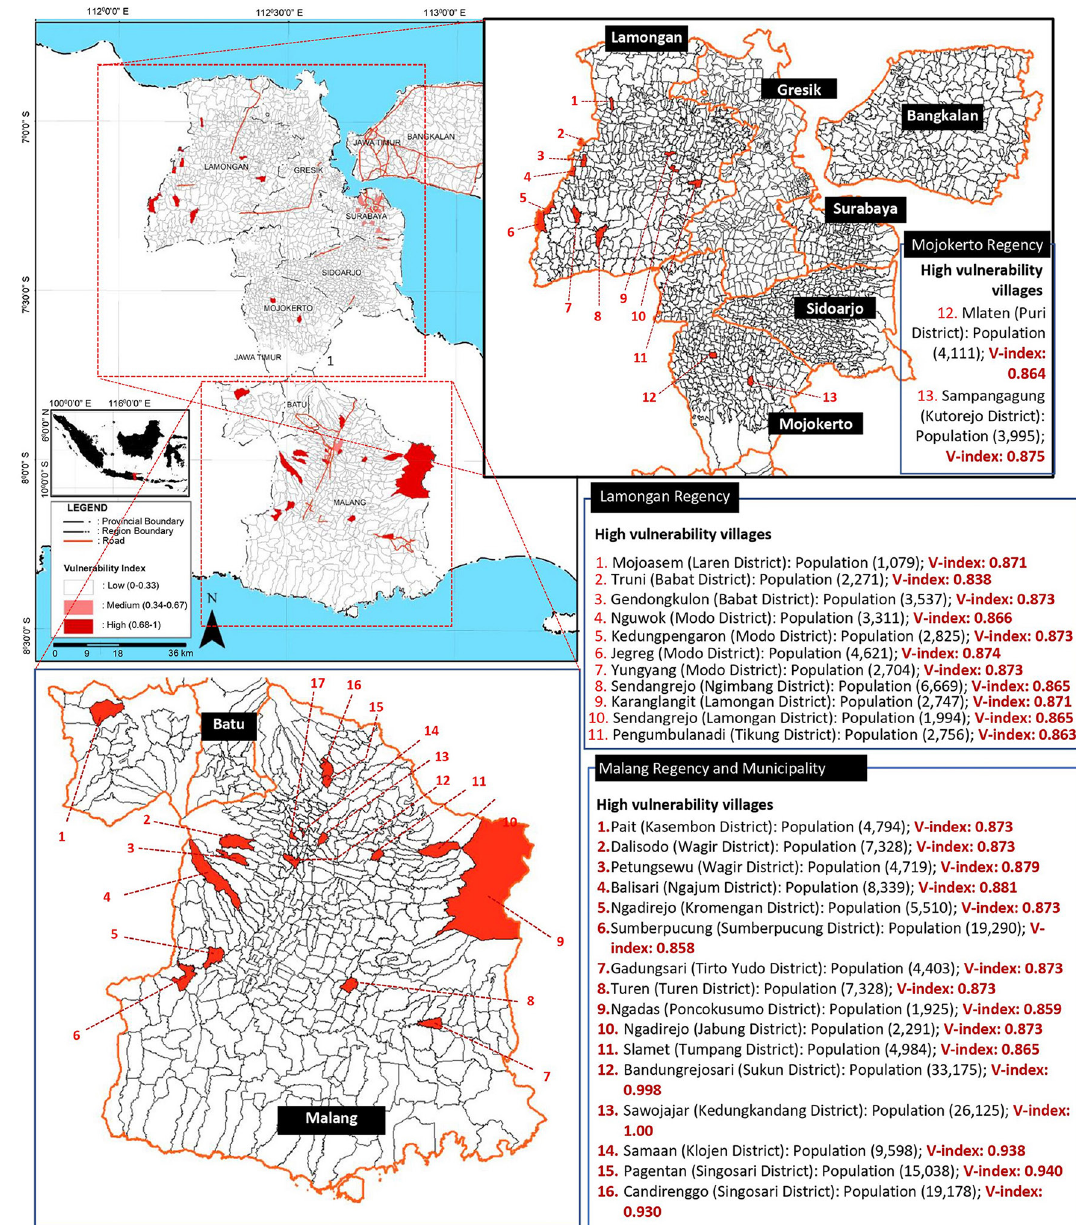
Fig. 10. Villages in Greater Surabaya and Batu-Malang regency/municipality having a high vulnerability